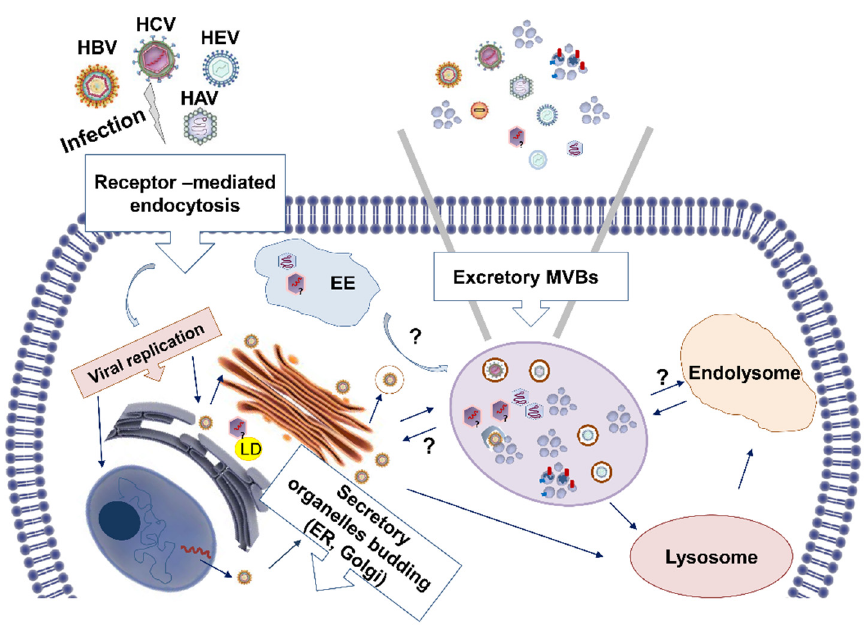
Figure 1. Schematic representation of the role of exosomes in the egress of hepatitis viruses. HBV, HCV, HAV, and HEV hijack the cellular endocytosis pathway to export intact virus, viral genetic material proteins packaged in exosomes. Key: EE: early endosomes; LD: lipid droplets; ?: unknown cellular events.